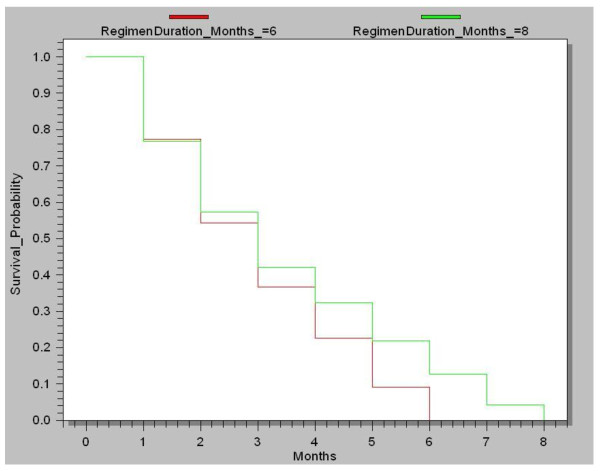
Kaplan-Meier curve for TB treatment defaulters (cases) remaining in treatment over time (for both six (N = 359) and eight-month (N = 586) regimens in Nairobi.